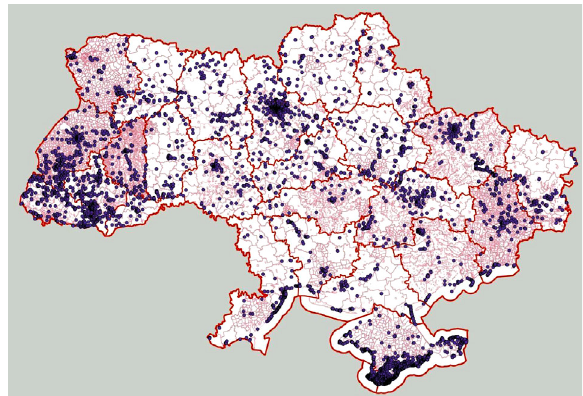
Figure 5. A heatmap (the distribution of tourist and recreational objects on the territory of Ukraine)